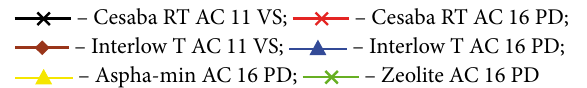
Fig. 1. Distribution of the average stability (a), flow (b) and bulk density (c) values of asphalt mixtures (at 60 ºC) depending on the amount of